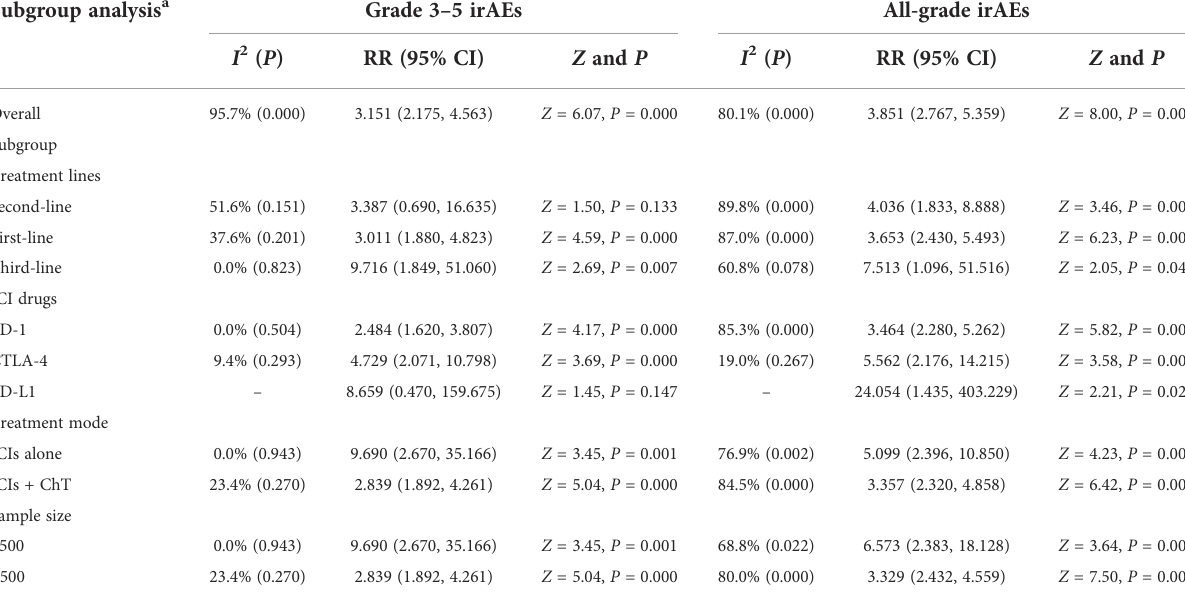
TABLE 3 Subgroup analysis of risk ratios for immune-related adverse events (irAEs) comparing ICI therapy with chemotherapy. Subgroup analysis